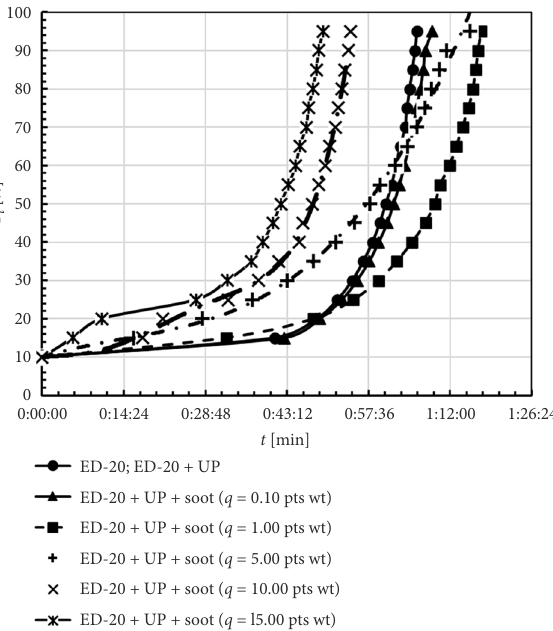
Figure 5. Torque variation in the process of curing of the epoxy resin with different concentrations of nanodispersed soot